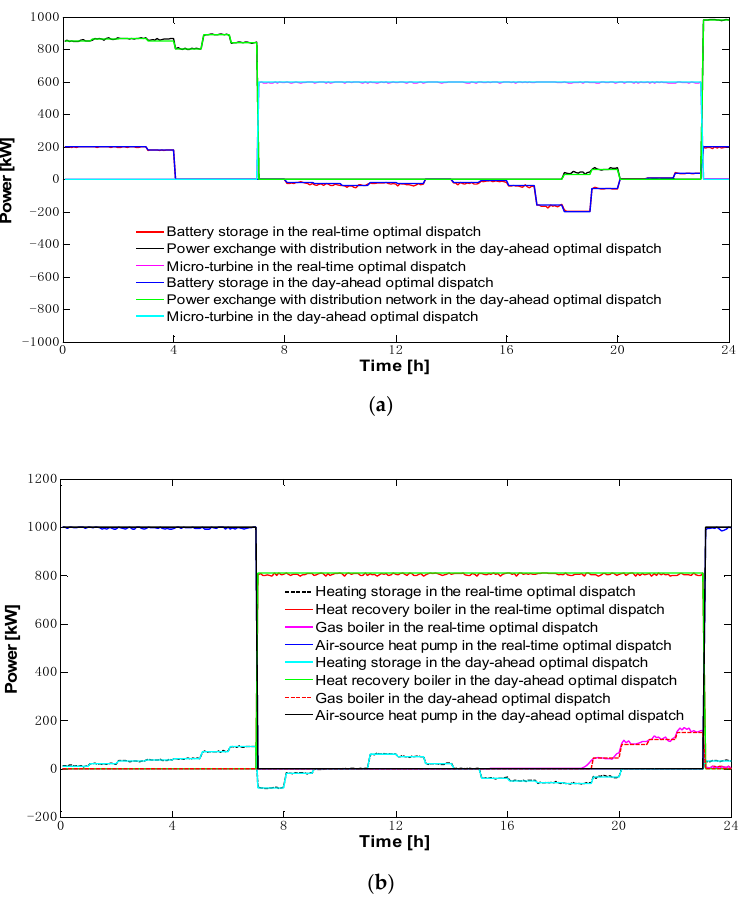
Figure 12. Comparison of electricity-supply units ( a ) and heating-supply units ( b ) in winter between the day-ahead optimal dispatch and the real-time optimal dispatch.